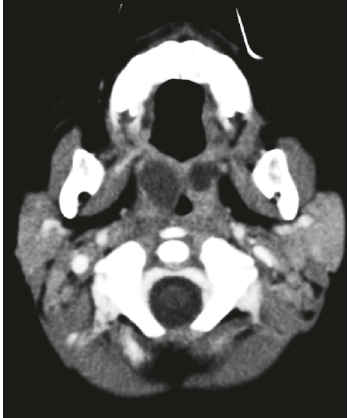
Figure 1: Contrast-enhanced computed tomographic scan, axial view.Enlargementofpalatinetonsilsandbilateralhypodensemasses with thick rim enhancement. Slight obliteration of the parapharyn- geal space.